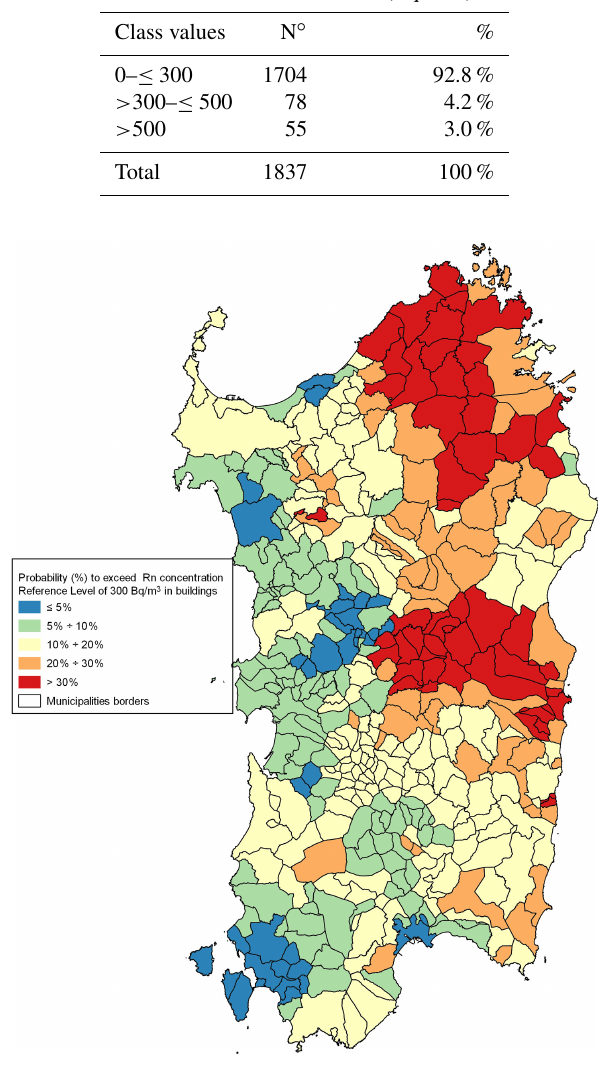
Figure 2. Classification of the regional territory of Sardinia and identification of radon risk